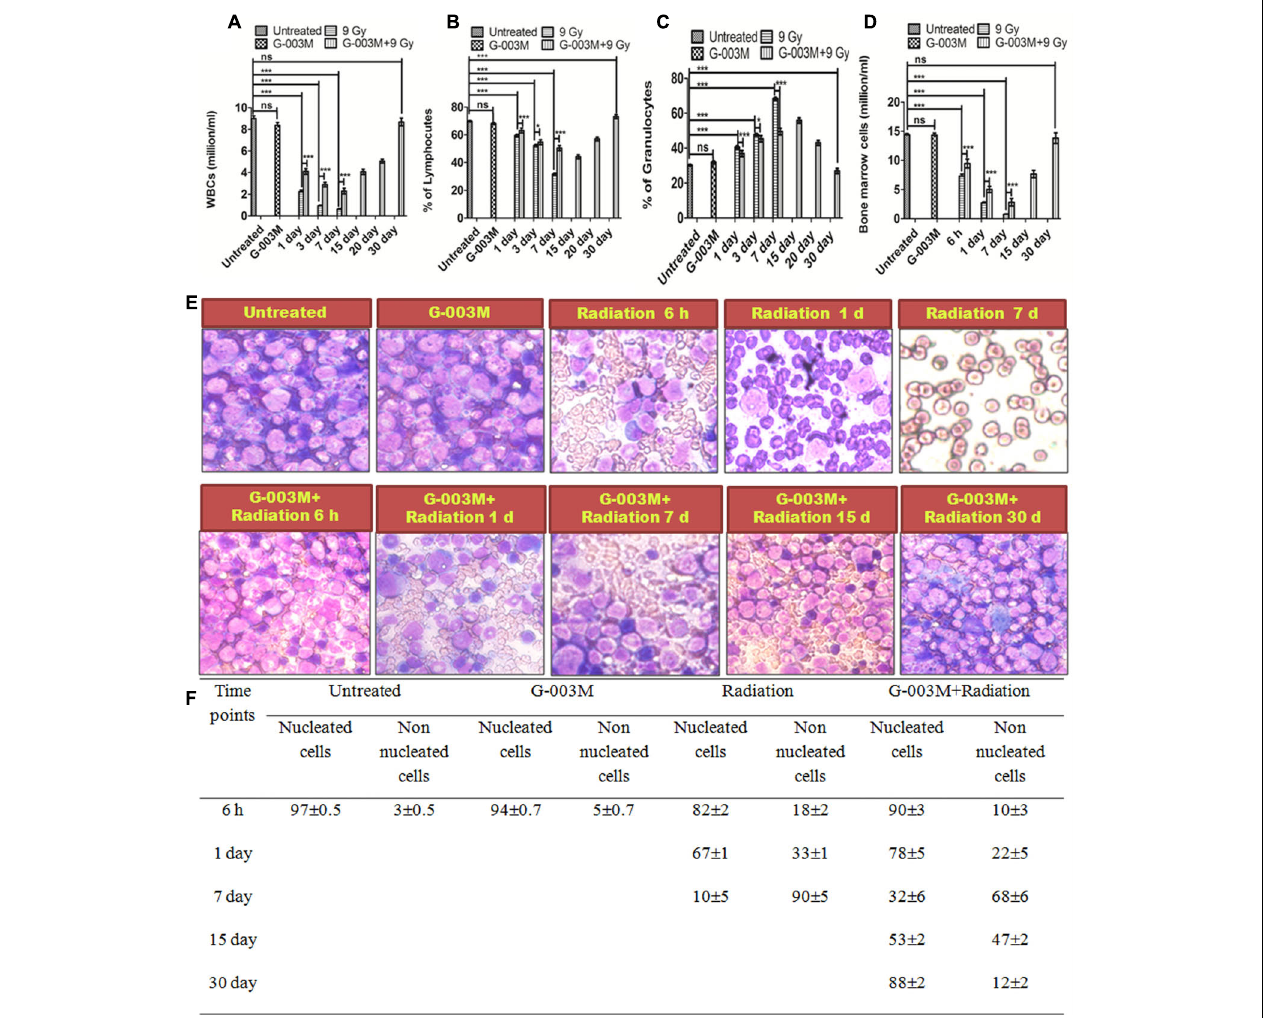
FIGURE 8 | Hematological recovery: (A) Graph represents the WBC counts at various time points and treatment groups. (B) Graph represents the percentage of lymphocytes at various time points and treatment groups. (C) Graph represents the percentage of granulocytes at various time points and treatment groups. (D) Graphs represent the bone marrow cell counts at 6 h, 1, 3, 7, 15, and 30 day time intervals in different treatment groups. (E) Bone marrow smear of Untreated, G-003M alone, Radiation alone and G-003M+ Radiation were observed under 40X magnification by staining with May-Grünwald Giemsa stain. (F) Table shows Effect of G-003M pre-treatment on bone marrow population of lethally irradiated mice at different time intervals. n = 6 per